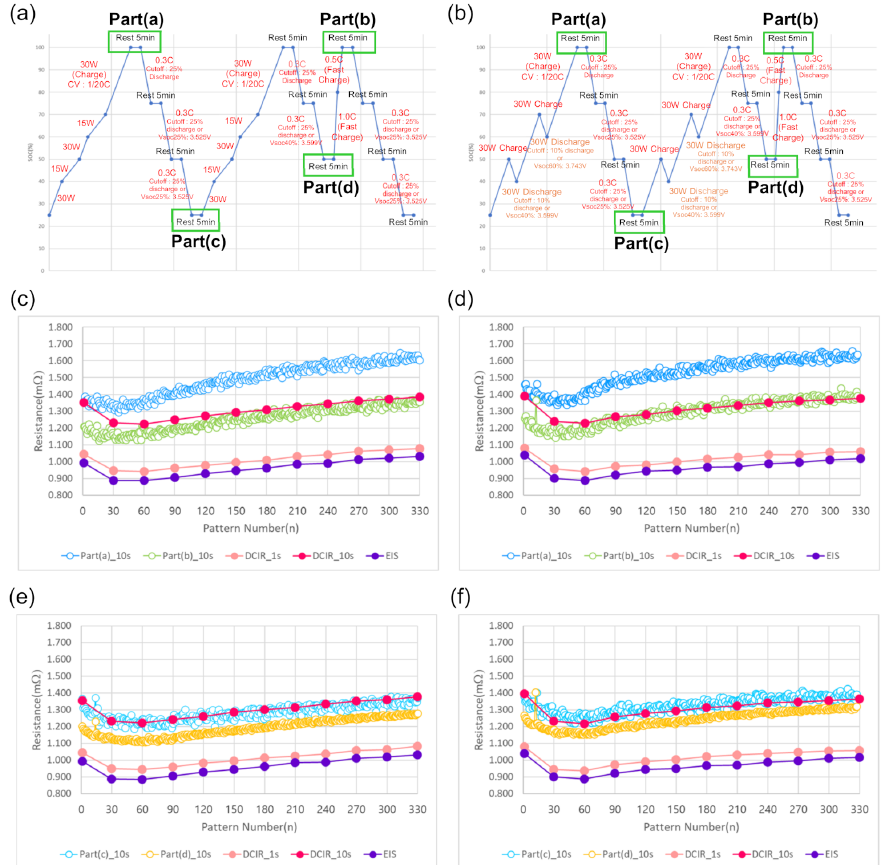
Figure 9. DCIR of the “stop-operation” part according to pattern repetition. ( a ) V1G pattern and the “stop-operation” part, ( b ) V2G pattern and the “stop-operation” part, ( c ) Comparison of DCIR between parts (a, b) (V1G), ( d ) Comparison of DCIR between parts (a, b) (V2G), ( e ) Comparison of DCIR between parts (c, d) (V1G), ( f ) Comparison of DCIR between parts (c, d)